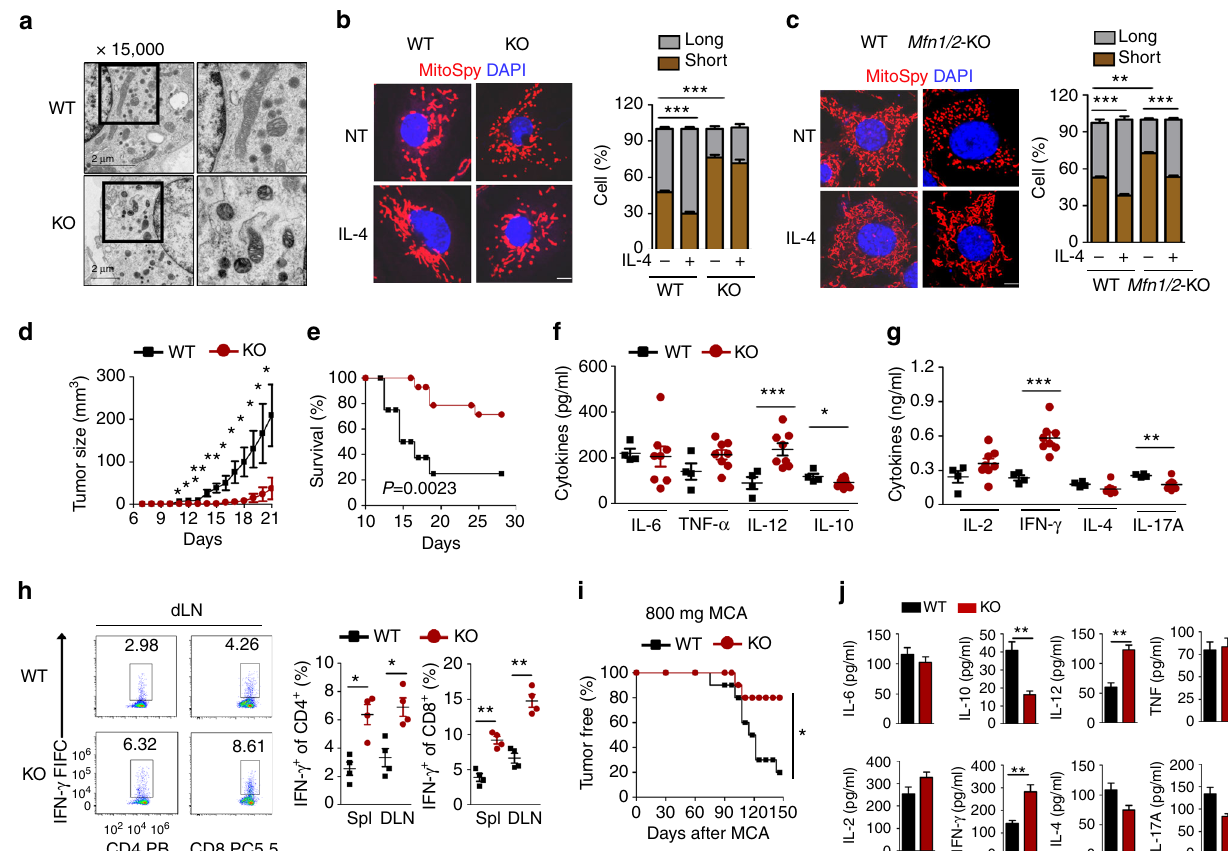
Fig. 2 FAM73b-de fi cient mice are resistant to tumor growth. a Electron microscopy of the mitochondrial morphology from WT and FAM73b KO BMDMs. b , c Representative confocal images and statistical analysis of the mitochondrial morphology from FAM73b KO BMDMs ( b ) or MFN1/2 KO MEFs ( c ). WT or FAM73b KO (KO) mice ( n = 14) were injected with 2 × 10 5 B16 melanoma cells. Tumor growth curve ( d ) and survival curve ( e ). ELISA assay to determine the various cytokine levels from innate ( f ) and adaptive ( g ) immunity in serum on day 15. h ICS and fl ow cytometric analysis of IFN γ + CD4 + and CD8 + T cells as described above, presented as a representative plot (left panel) and a summary graph (right panel). The percentage is based on total CD4 + or CD8 + T cells. i , j WT or FAM73b KO mice ( n = 10) were injected with 800 μ g of MCA. Frequency of tumor-free mice ( i ). The indicated cytokines were detected in the serum of WT or FAM73b KO mice via ELISA. The serum was collected from the mice on day 150 after injection of MCA ( j ). All the data are representative of three independent experiments. Scale bar in a is 2 μ m; those in b and c are 5 μ m. Error bars are mean ± SEM values. Two-tailed unpaired t -tests were performed. * P < 0.05; ** P <